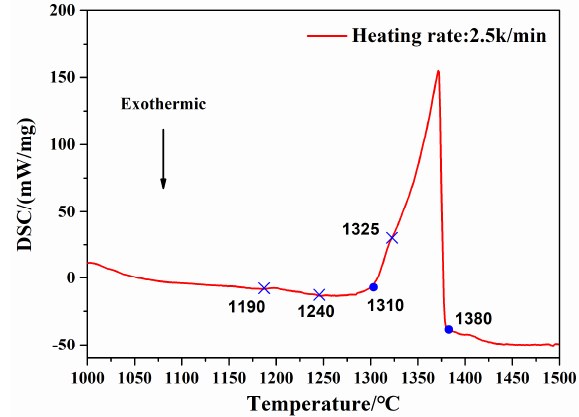
Figure 3. Heating differential scanning calorimetry (DSC) curve of the as-cast GTD222 superalloy with a heating rate of 2.5 K/min.